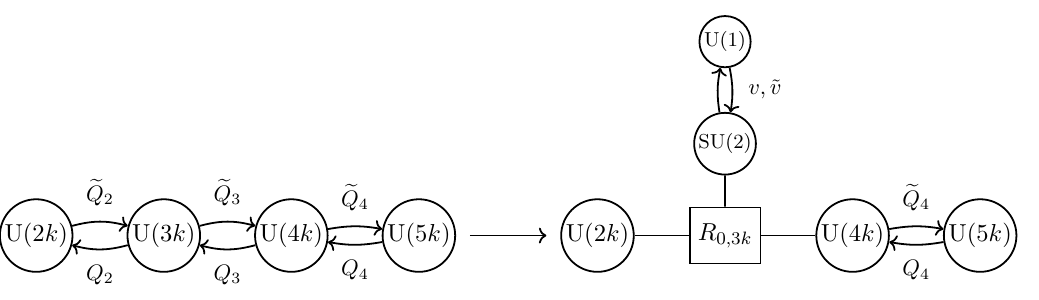
v β is equal α v β squares to zero. Overall, this α